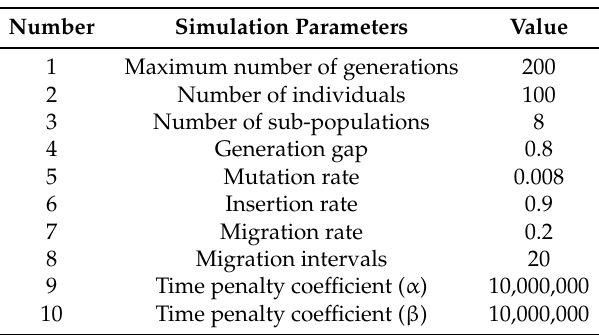
Table 9. Simulation parameters of